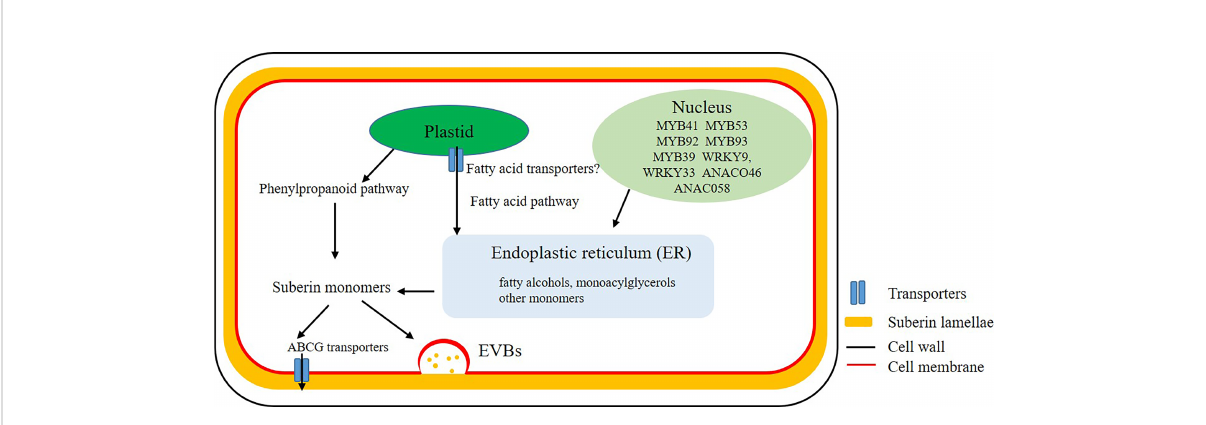
FIGURE 1 Biosynthesis and transport of suberin. Mostly biosynthesis of suberin monomers take place at the endoplasmic reticulum (ER). After a series of complex enzyme-induced reactions, fatty acids and other lipids in plastid are transported to the ER to synthesize fatty alcohols, monoacylglycerols and other monomers. Monomers, oligomers or polymers are probably transported cross the plasma membrane by ATP- binding cassette (ABC) transporters or Extracellular Vesiculo-tubular containing Bodies